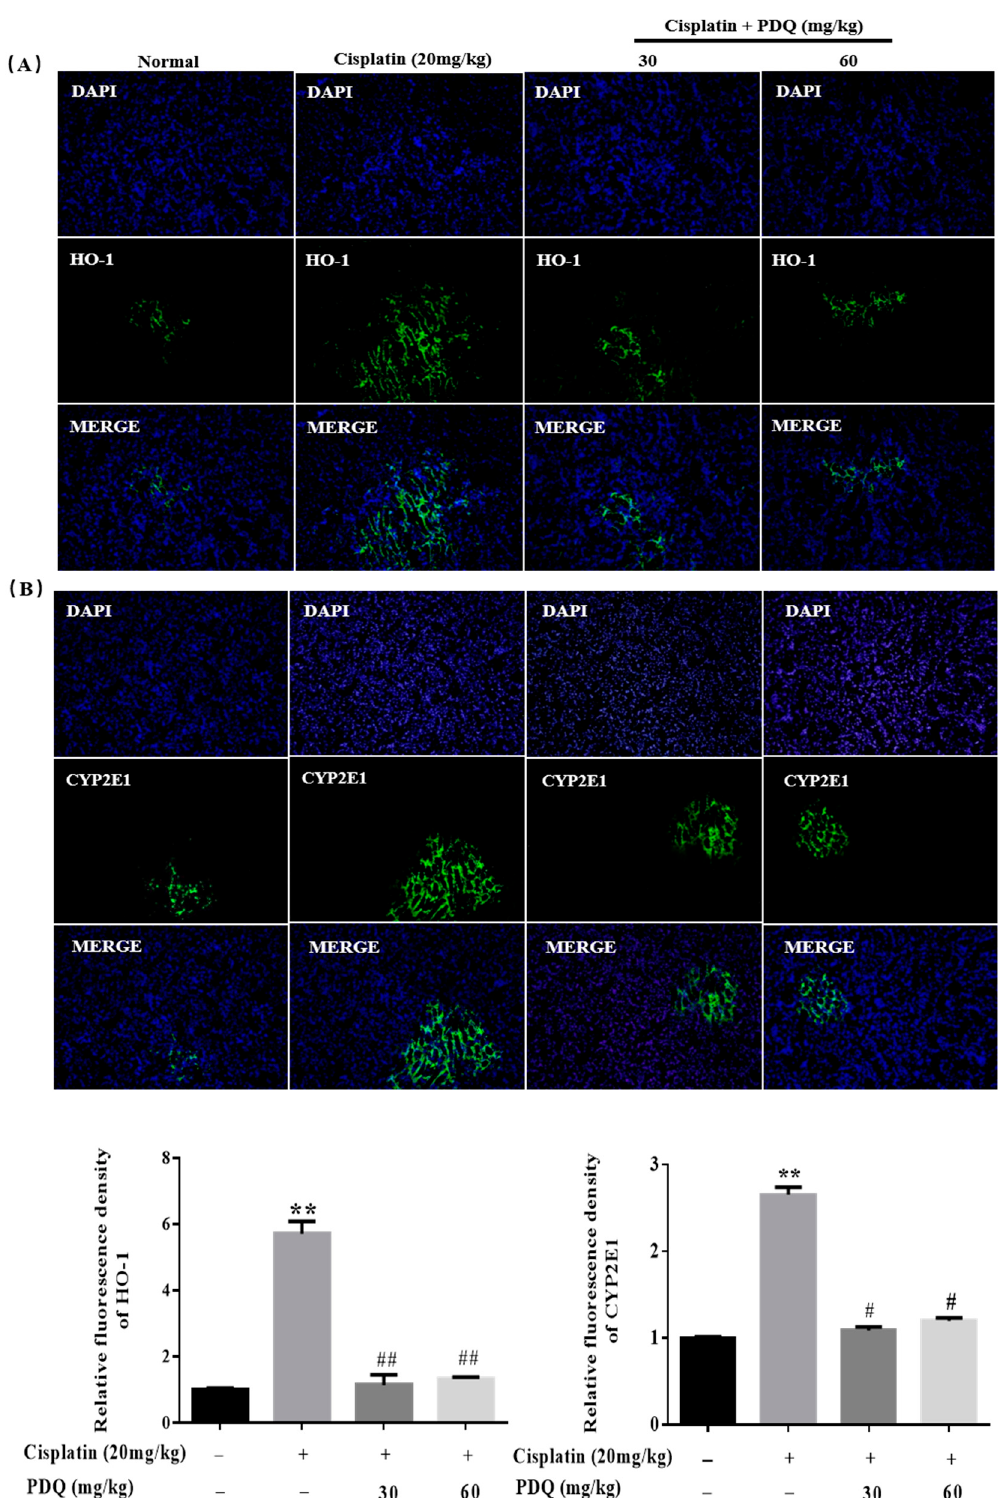
Figure 6. Pretreatment with PDQ inhibited the cisplatin (CDDP)-induced increase of heme oxygenase 1 (HO-1) (green) ( A ) and cytochrome P450 E1 (CYP2E1) (green) ( B ) in renal tubular epithelial cells. The expression levels of HO-1 and CYP2E1 were assessed by immunofluorescence staining (magnification, 200 × ). n = 8, ** p < 0.01 vs. control group; # p < 0.05, ## p < 0.01 vs. cisplatin group. DAPI (blue) was used as a nuclear counterstain.